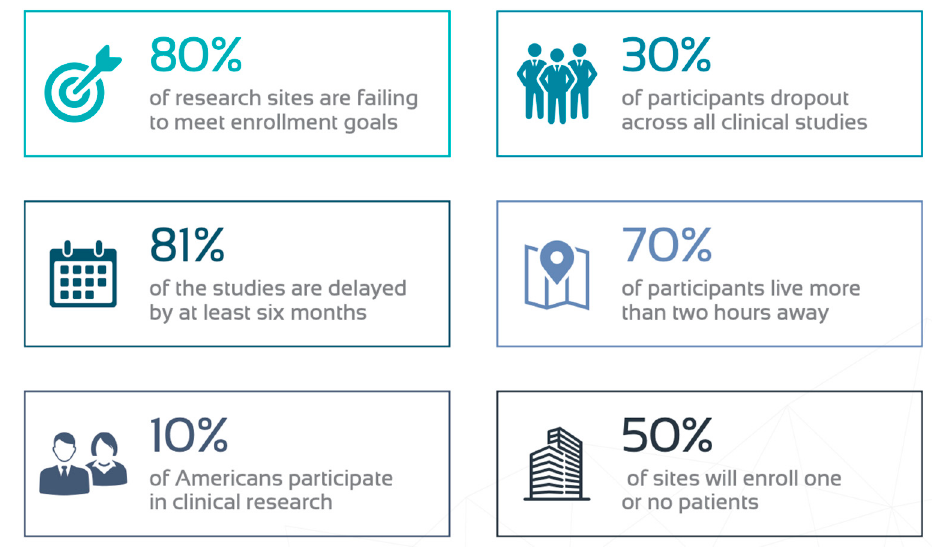
Figure 2. Challenges with traditional RCTs [6–12].